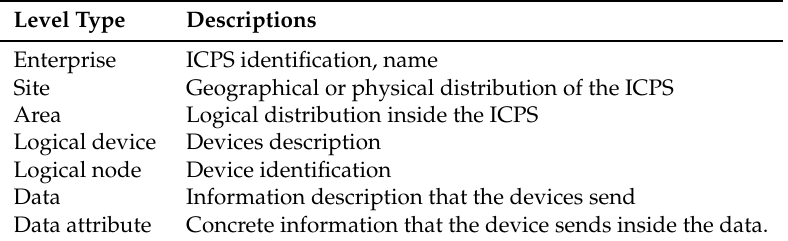
Table 3. The level types of the Data